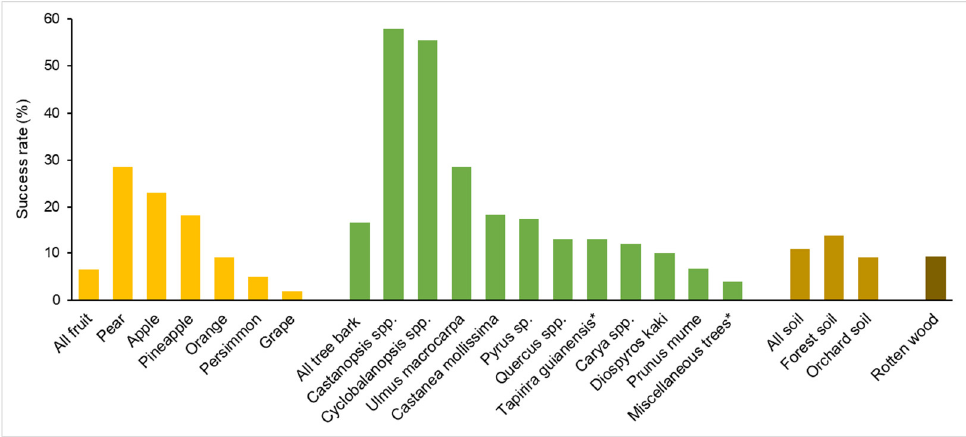
Figure 2. Success rates of S. cerevisiae isolation from different substrates in the wild. Data are from Wang et al. [20] except those marked with an asterisk which are from Barbosa et al. [59]. The substrates with more than ten samples subjected to S. cerevisiae isolation are selected. The types of the substrates (fruit, tree bark, soil and rotten wood) are distinguished using different colors and the specific substrates in each group are arranged according to the success rates of S. cerevisiae isolation.